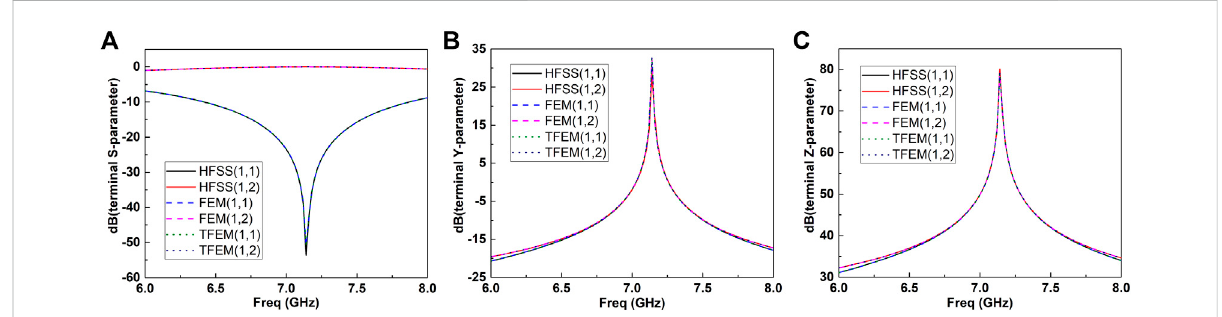
FIGURE 5 Comparisons of terminal (A) S-parameters, (B) Y-parameters and (C) Z-parameters of the coaxial cable among HFSS, FEM and the developed tool (TFEM).